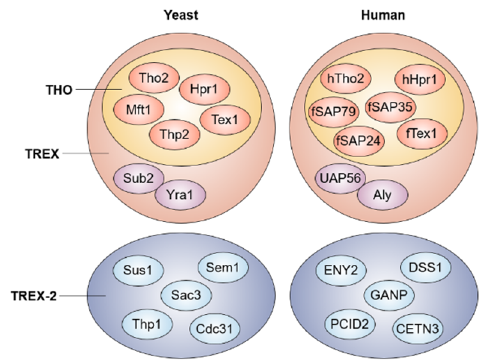
Figure 1. The conserved TREX and TREX-2 complexes. Both TREX and TREX-2 complexes are con- served between yeast and human. The TREX complex includes the multi-subunit THO complex and mRNA export proteins.